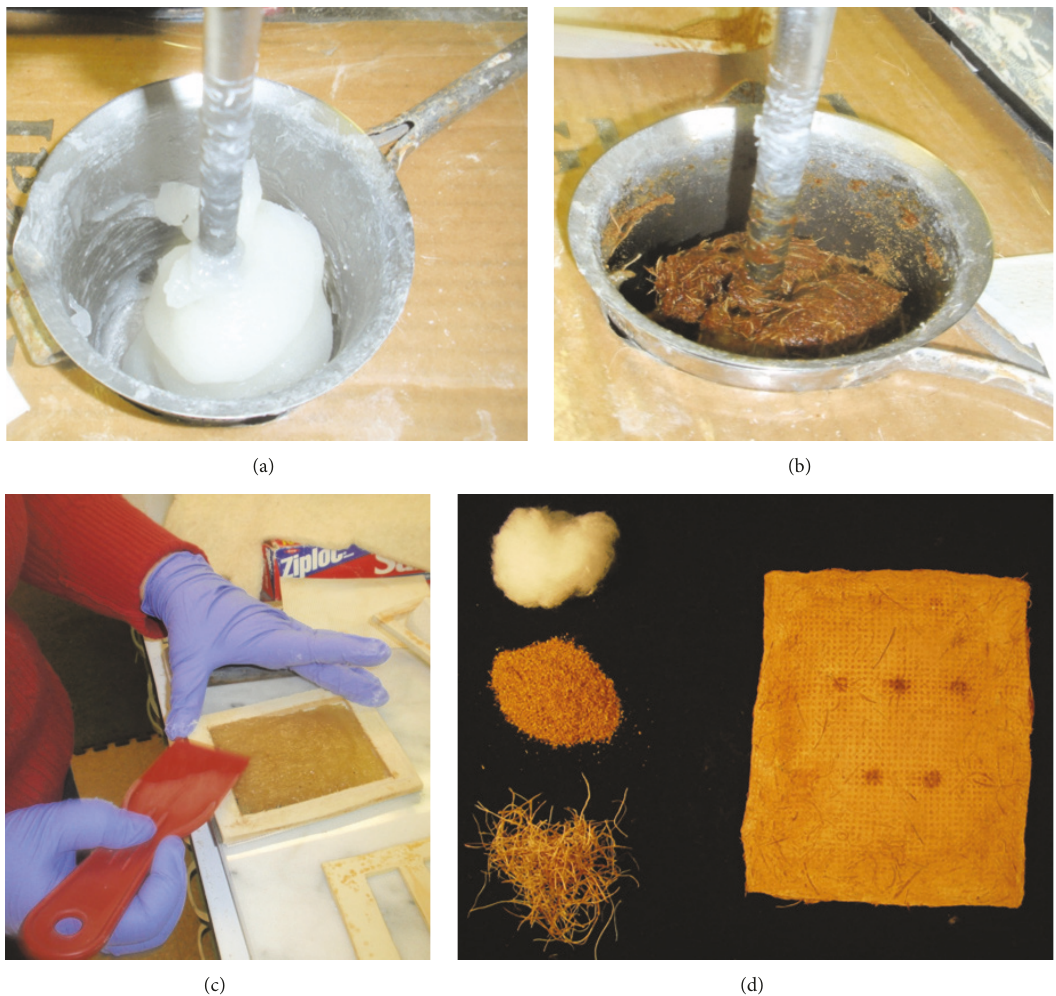
Figure 1: Preparation of LC panels. (a) Cotton gel first prepared by stirring cotton in cold alkaline solvent, (b) cotton gel combined with OOW and AF ingredients and stirred, (c) the resultant LC gel transferred to foam panel and then transferred to water to remove alkaline solvent, and (d) representation of the final composite and the original ingredients (cotton, OOW, and AF) employed.